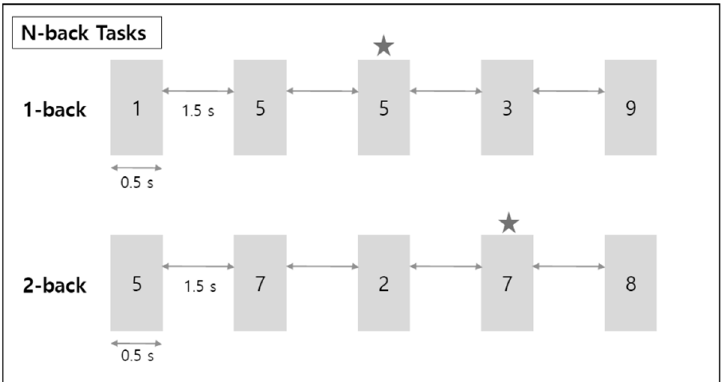
Figure 2. Schematic diagram for n-back working memory task. ★ refers to the target number; when this number appears, the correct button must be pressed.